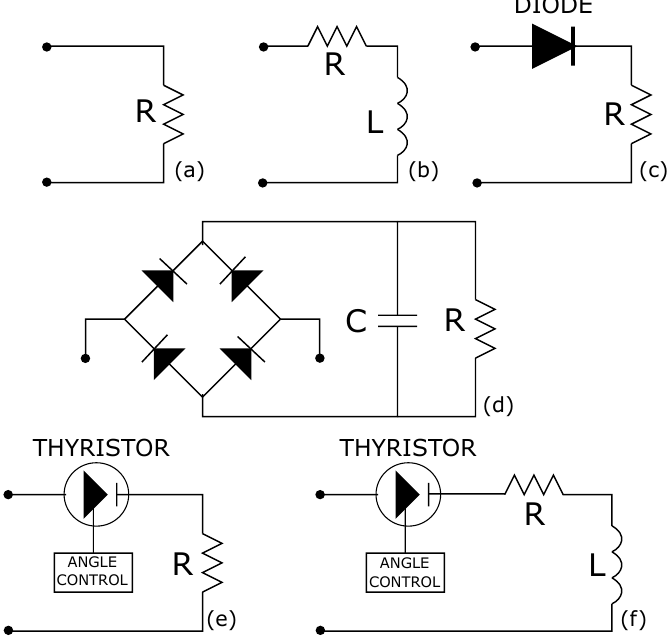
Figure 6. Diagrams of simulated loads, being ( a ) resistor, ( b ) resistor and inductor, ( c ) diode rectifier with resistor, ( d ) diode bridge with resistor and capacitor, ( e ) thyristor rectifier with resistor, ( f ) thyristor rectifier with resistor and